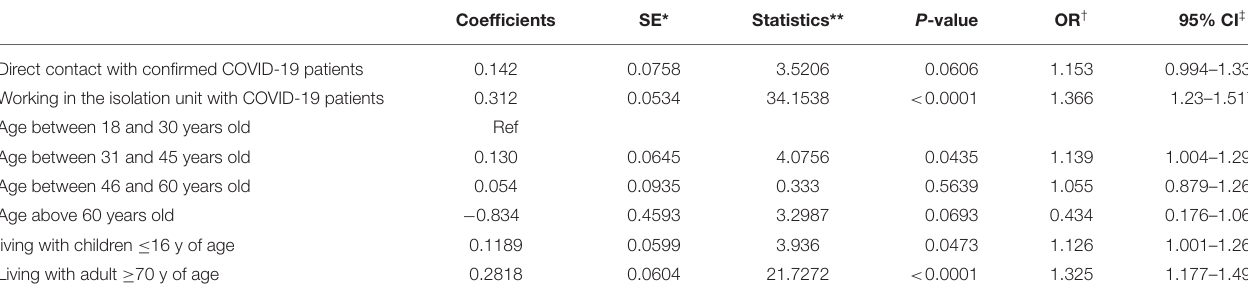
TABLE 3 | Factors associated with depressive symptoms by multivariate